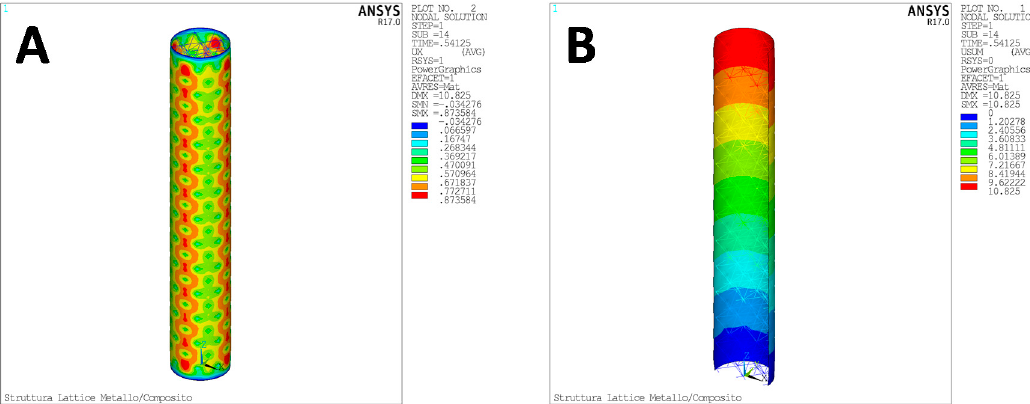
Figure 24. Test case 2—Non-linear analysis. Radial displacement (A) and total displacement (B) at local buckling.